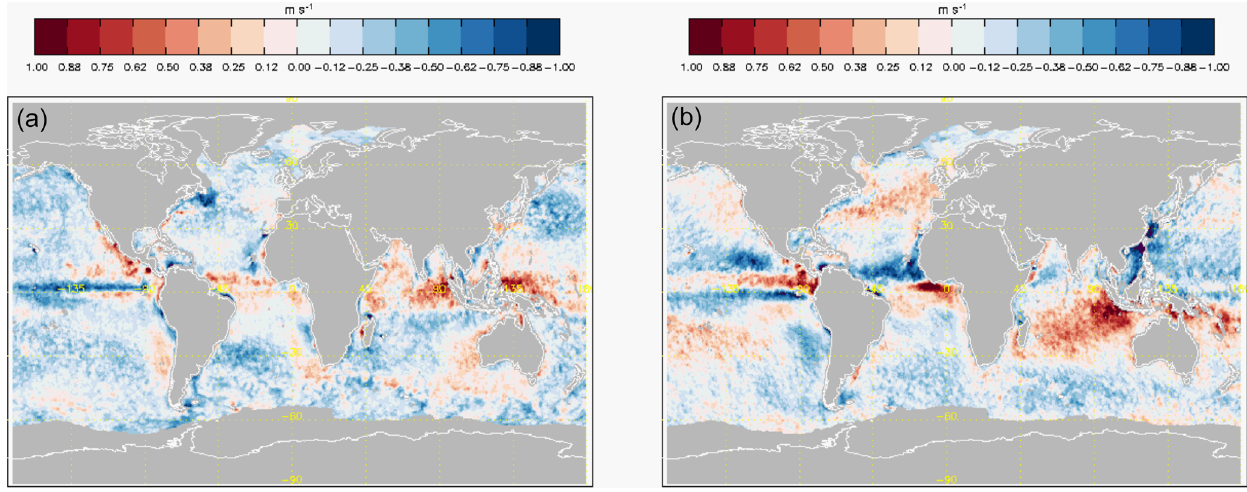
Figure 12. Zonal (a) and meridional (b) mean wind differences between ASCAT and ERA5 first-guess winds over 2016 after ocean current correction.